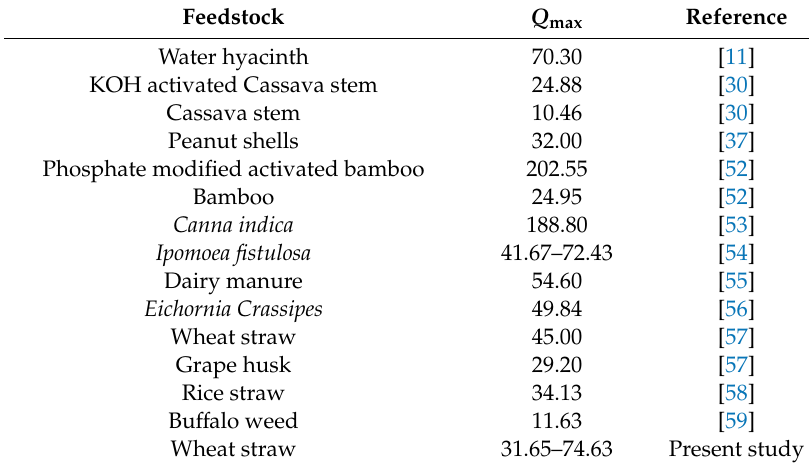
Table 4. Comparative analysis of sorption capacity (mg / g) of various plant-based biochars.